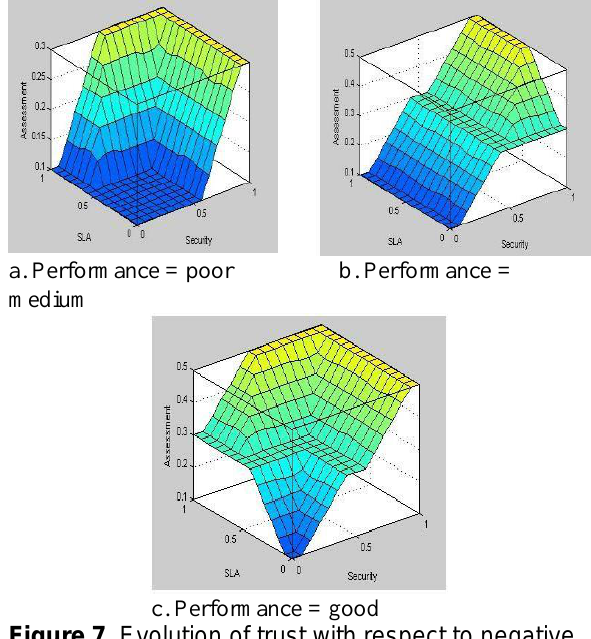
Figure 7. Evolution of trust with respect to